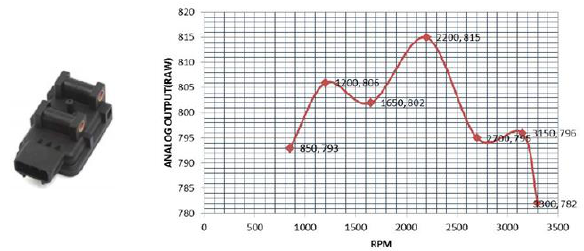
Fig. 9. Manifold Absolute Pressure Sensors with analog output vs. rpm